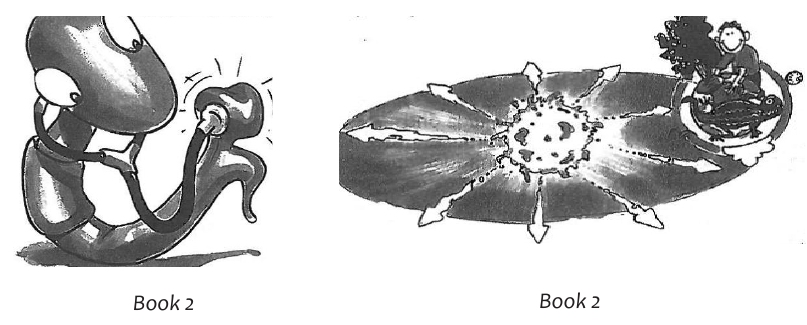
Figure 12: Unmentioned picture